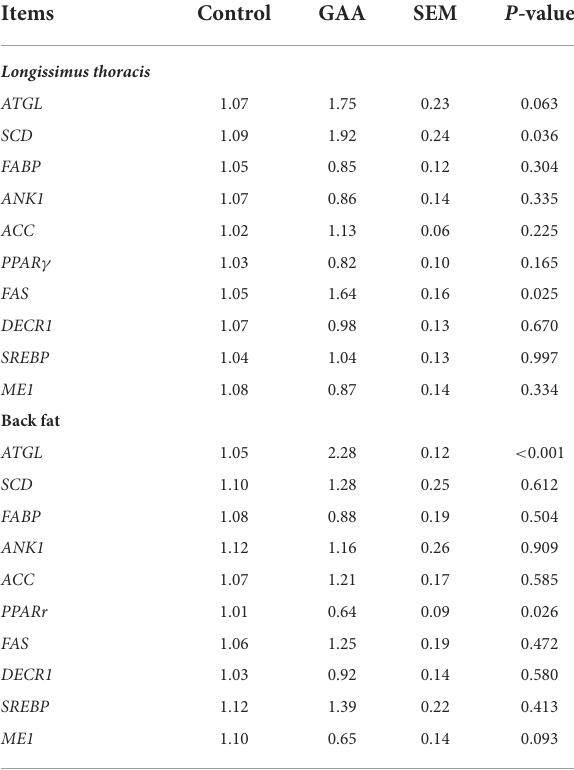
TABLE 7 Effect of dietary GAA on expression of lipid metabolism-related genes in Longissimus thoracis and back fat of Tibetan